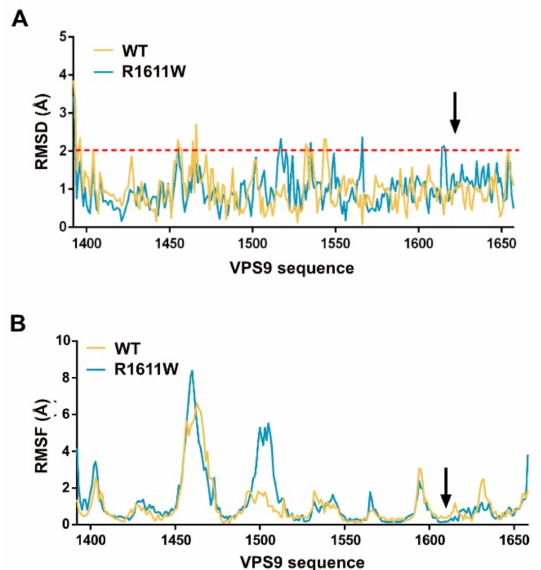
Figure 3. VPS9 stability profile. ( A ) Average RMSD of VPS9 residues after minimization. The red dashed line marks the threshold of commonly allowed RMSD to define structural similarity. ( B ) Flexibility analysis of VPS9 core structure performed with CABS-flex